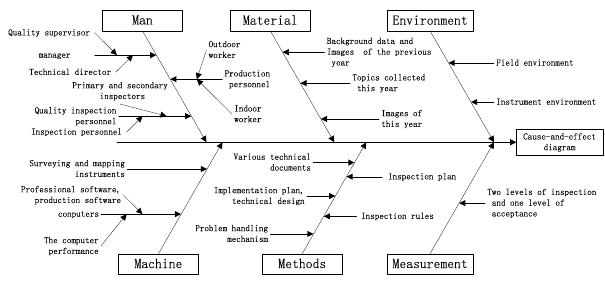
Figure 4. Fundamental geographic national conditions